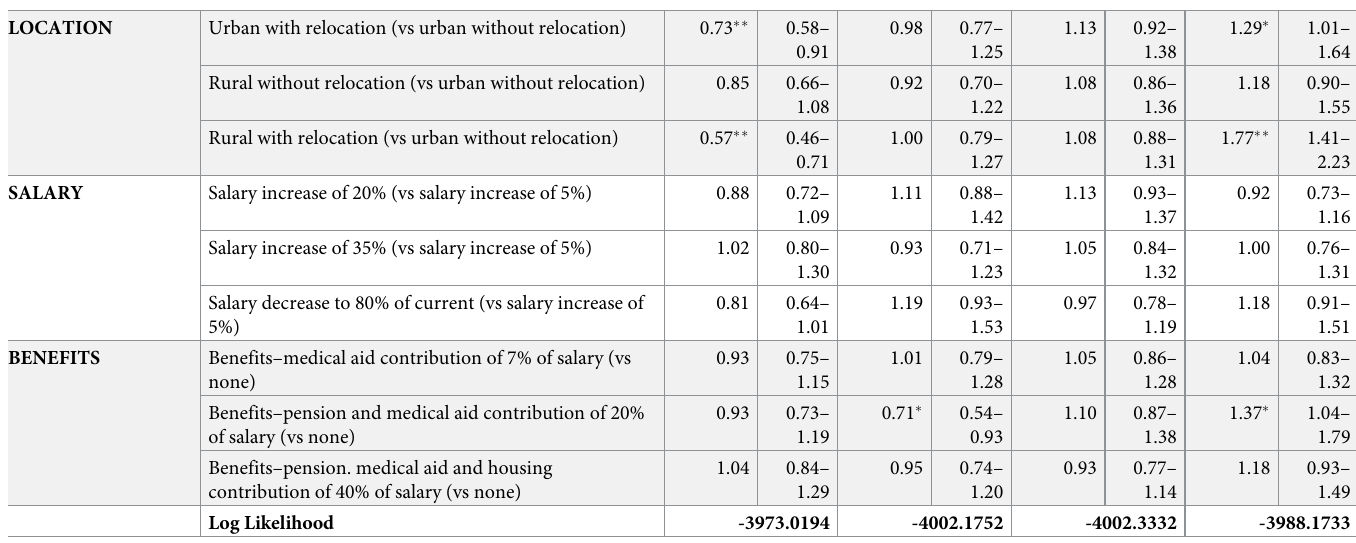
Note: Interaction terms were created by multiplying a dummy variable for each group by each attribute level and running a regression with both the original level variables and all interaction terms (e.g. for general practitioners, the dummy variable is set equal to 1 if the person is a general practitioner, and 0 for all other cadres). The top half of the table shows the odds ratios of the attribute level versus the baseline for the sample, excluding those in the specific interaction. The bottom half of the table should be interpreted for the specific cadre interaction in relation to the rest of the population, showing where preferences for each particular cadre diverge from the preferences of the rest of the